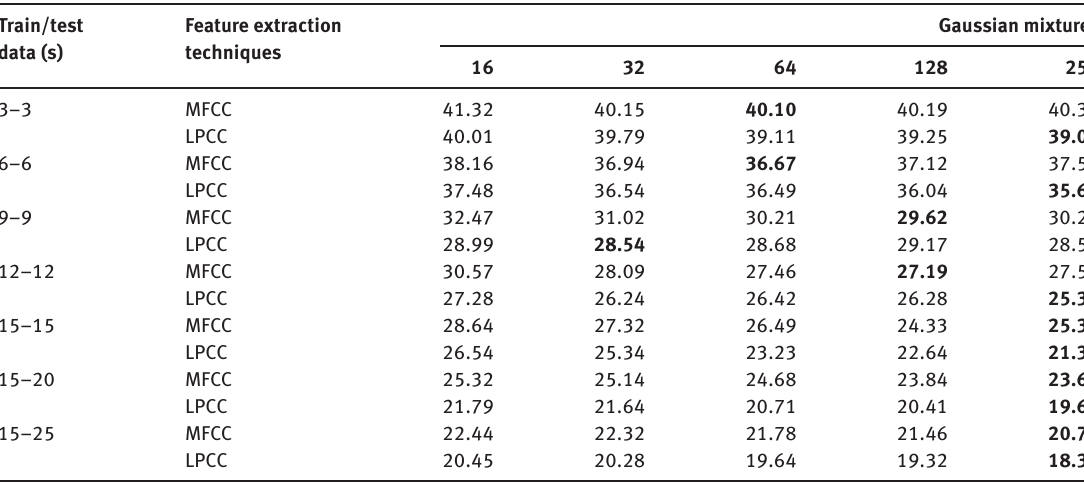
Table 4: EER of the Speaker Verification System Using MFCC and LPCC Features (13 Dimensions) and GMM–UBM Modeling for the NIST 2003 Data